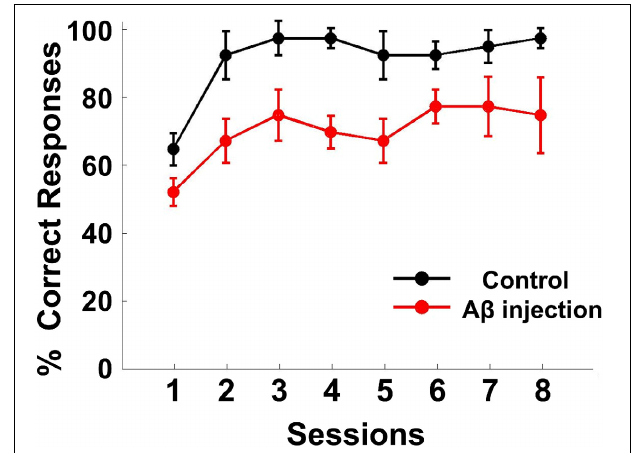
FIGURE 4 | Behavioral performance. Task performance rates of the delayed alternate choice for the two groups. The curves show the mean percentage of correct responses in the A β group (red) and control group (black). The error bars indicate